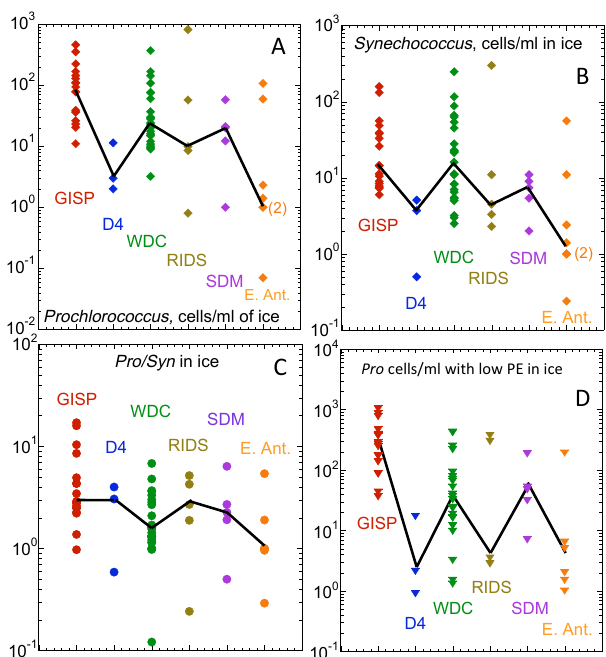
Fig. 9. Concentrations of cells from 8 different locations (including South Pole, Dome C and the US-Norway traverse in E. Antarctica), taking into account centrifuging and sample volume: (A) Pro -like: (B) Syn -like; (C) Pro -like/ Syn -like; (D) Pro -like, but with low